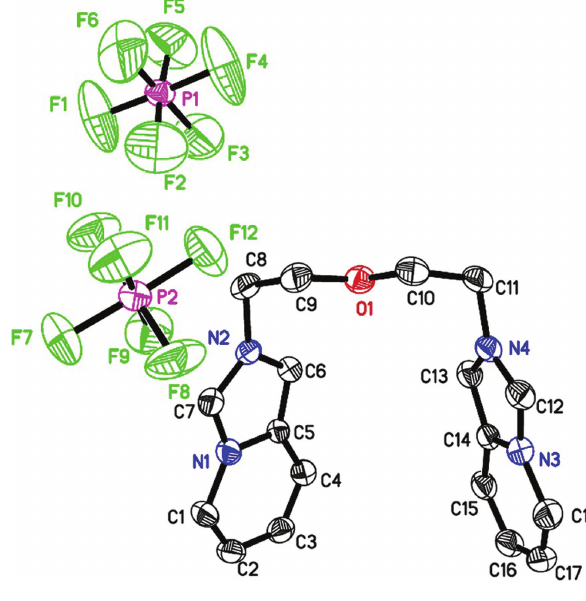
Table 1: Data collection and handling.